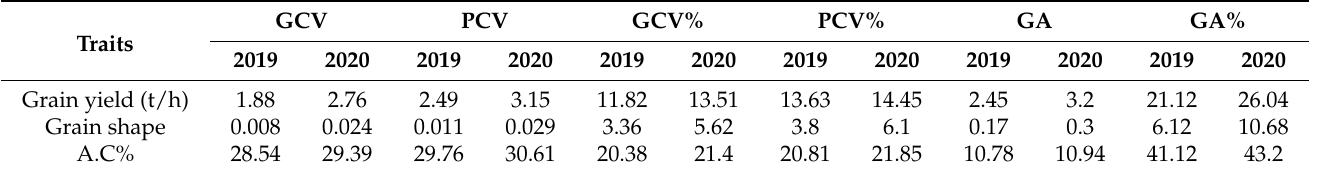
Table 8. Estimates of variability parameters for the grain yield, grain shape (L/B ratio), and amylose content percentage in rice lines over two years.